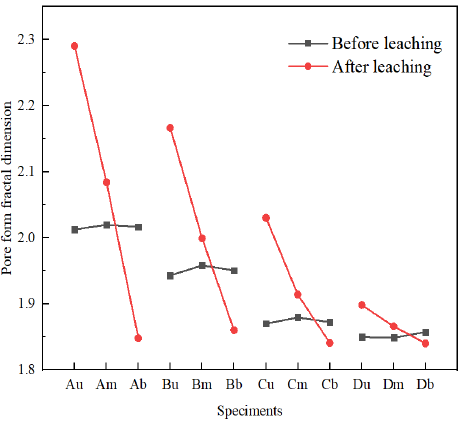
Figure 8. Change rules of fractal dimension of pore shape.